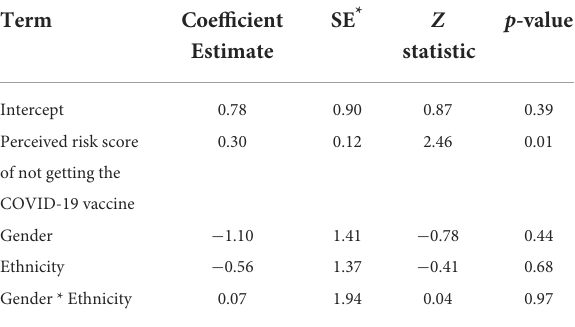
TABLE 5 Logistic regression model results for COVID-19 vaccination status (not vaccinated = 0; vaccinated = 1) on the perceived risk